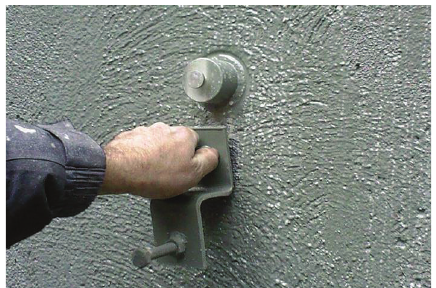
Figure 4: Pull-off test.